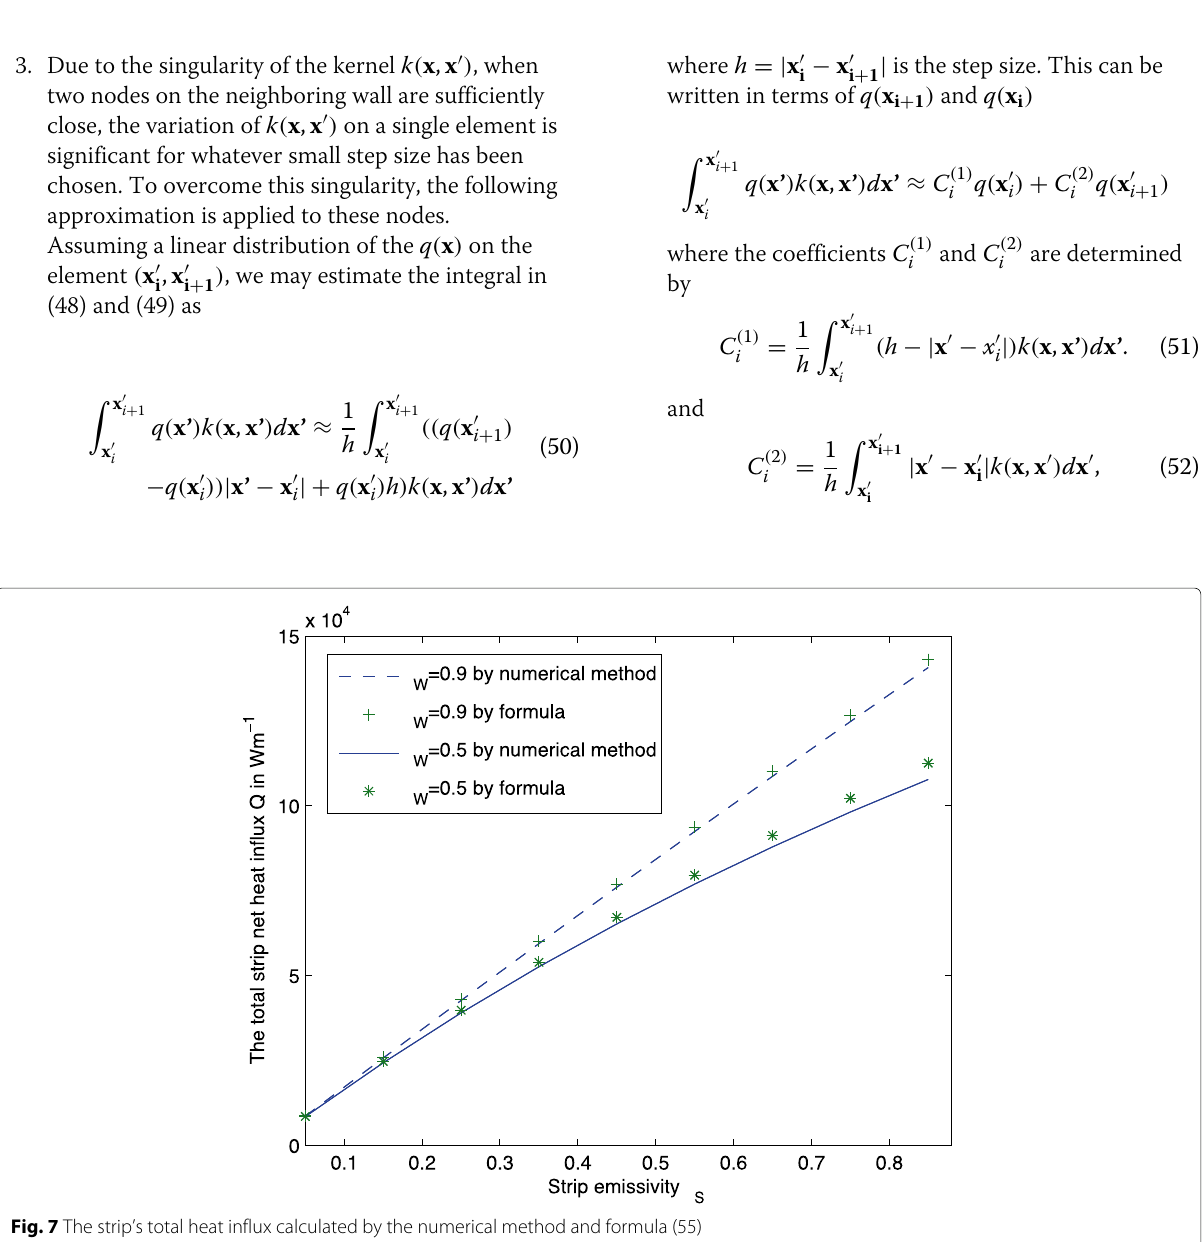
Fig. 6 Shadow effect of the strip